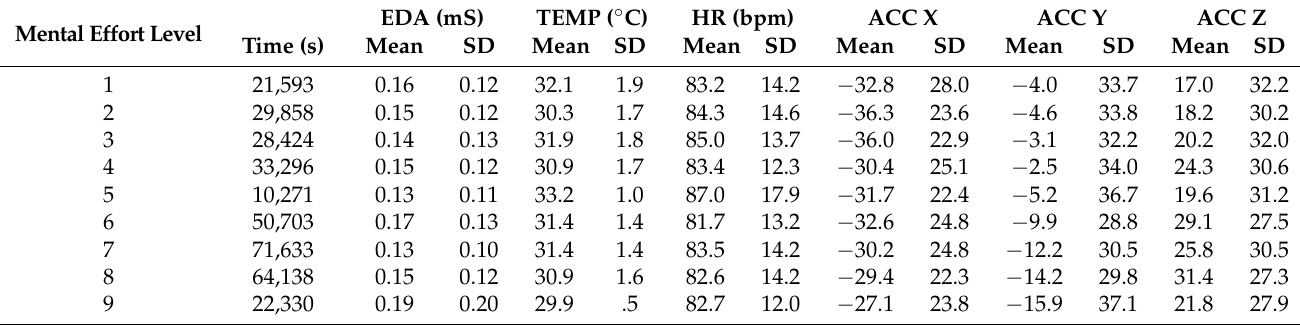
Table 1. Descriptive analysis of the physiological features extracted from the Empatica E4. Mental Effort